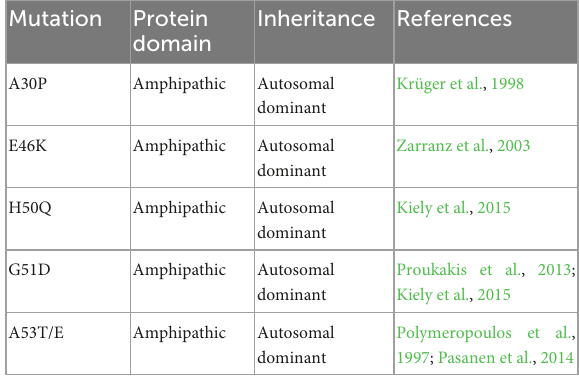
TABLE 1 SNCA single nucleotide variants linked to PD